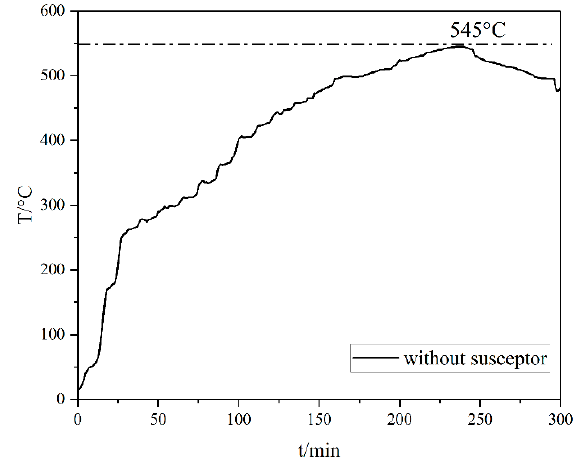
Figure 3. Temperature rise curve without a susceptor.